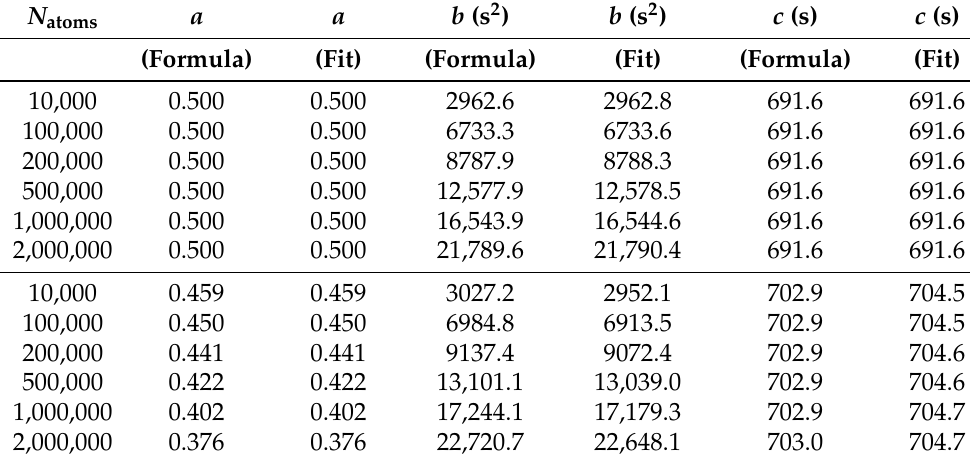
Table 1. Comparison of the fitted values of the parameters, a , b , and c with their values predicted by Equations (26)–(28) when cloud–cloud interactions are turned off. The top half of the table gives results for a harmonic potential and the bottom half for anharmonic potential.